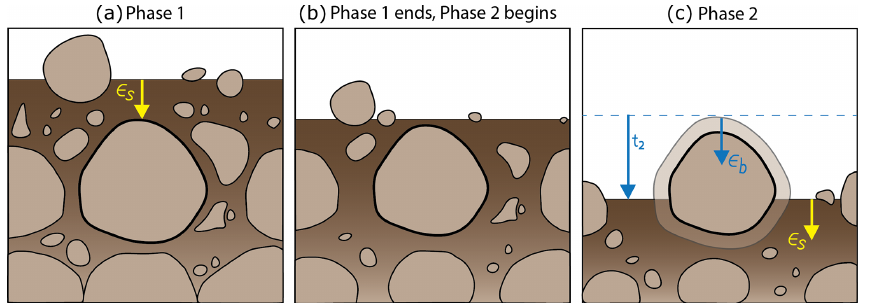
Figure 3. Schematic image showing the process of boulder exhumation. (a) Overview of the setting: a mixed soil- and bedrock-covered hillslope where sediment size decreases with decreasing fracture spacing. (b) During phase 1, the boulder is buried and accumulates nuclides at a rate governed by the soil denudation rate, (cid:15) s . (c) Phase 1 ends when the boulder breaches the soil surface. (d) During phase 2, the boulder itself is eroding at a rate of (cid:15) b , and the surrounding soil continues to denude at a rate of (cid:15) s . Phase 2 lasts for a time period t 2 that ends with our